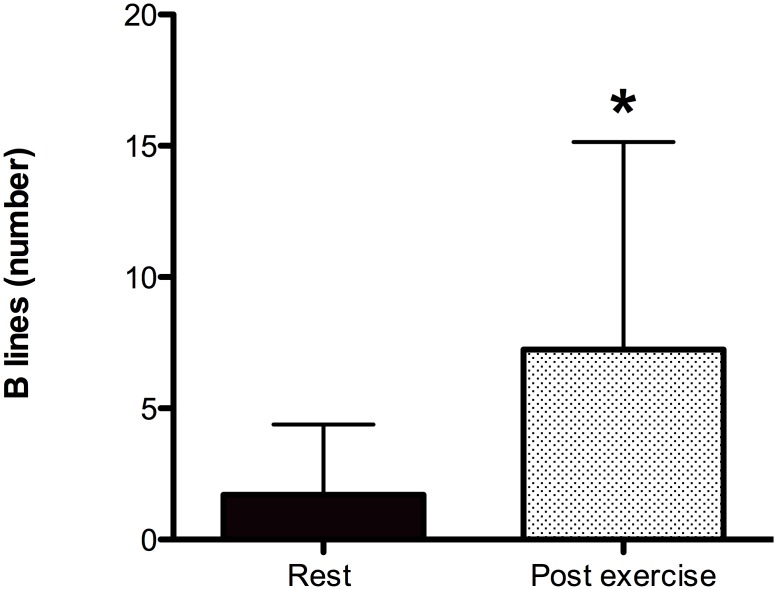
Thoracic ultrasound evaluation (US-B lines) at rest and after the run.Ultrasound echo evaluations performed before and immediately after the run showed increased interstitial lung edema, which was identified by the presence of US-B lines. *Student’s t-test, p<0.001.